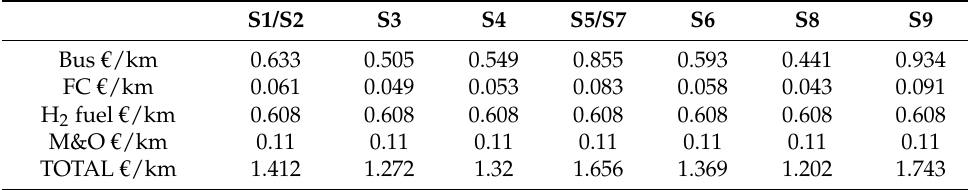
Table 12. TCO calculated for dataset related to 2030.